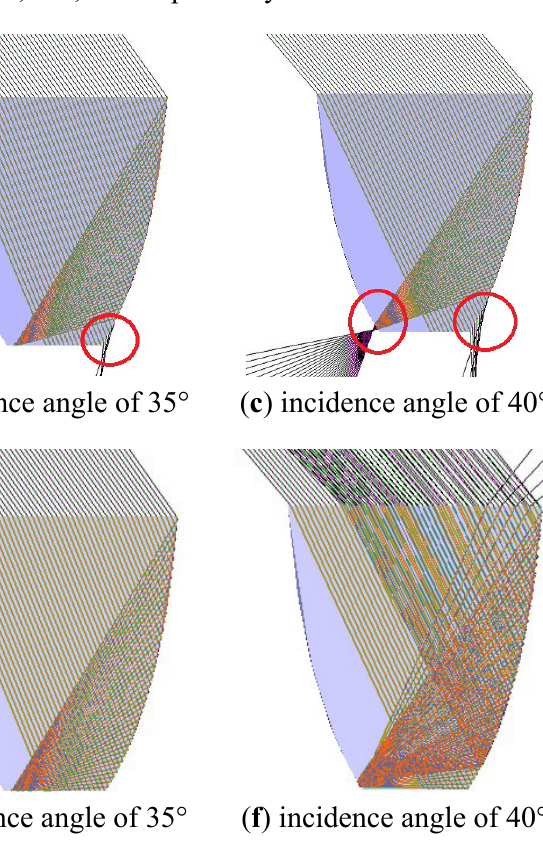
Figure 4. Schematic diagram of ray tracing results for the experimental solid